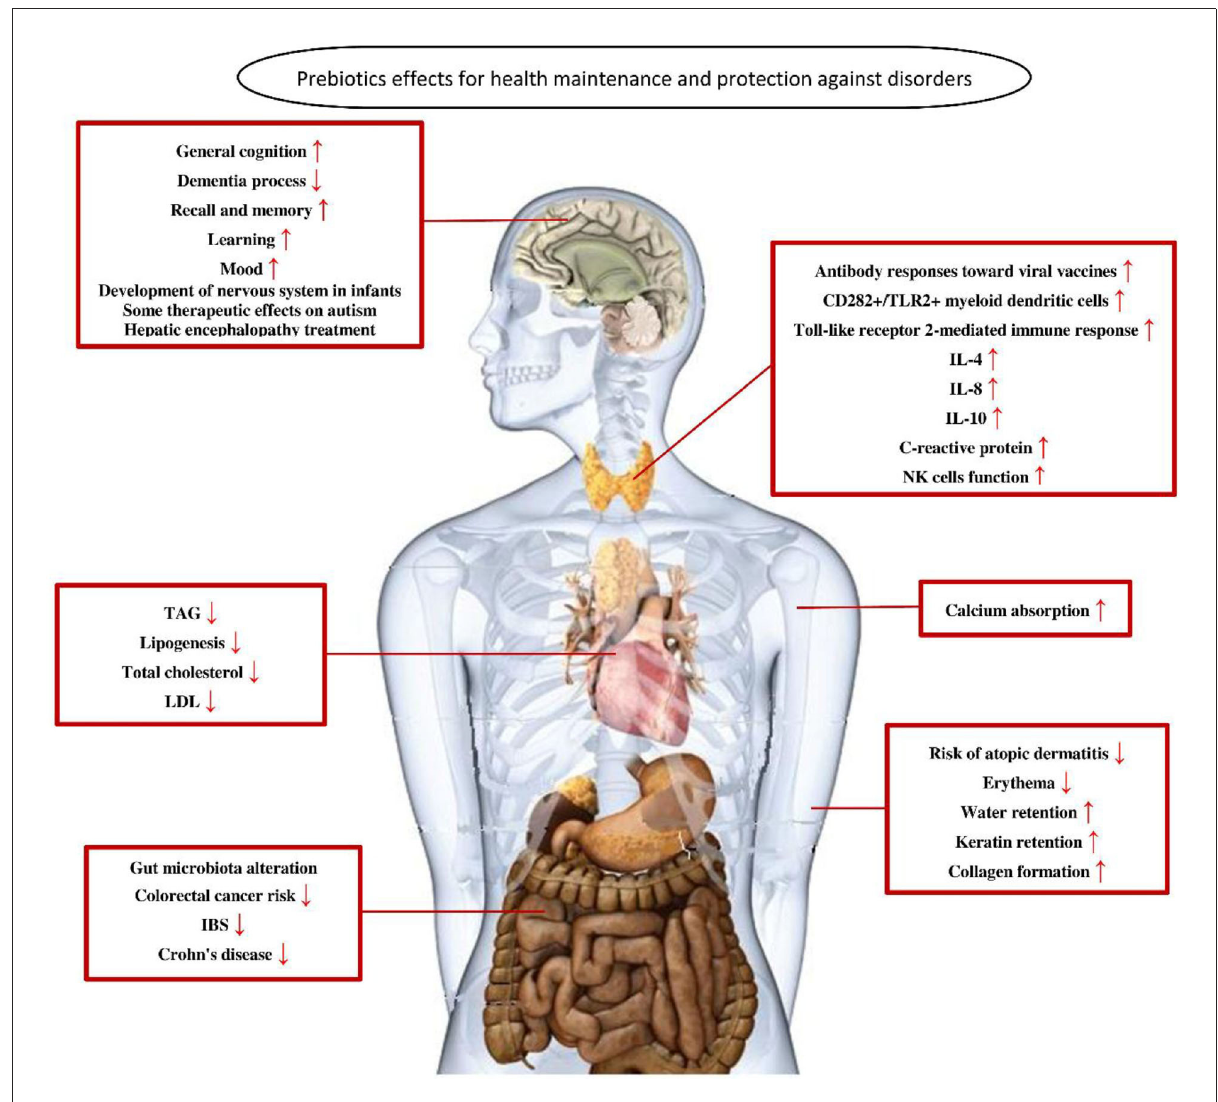
FIGURE3 The role of prebiotics in maintaining health and preventing disorders (68). TAG, triacylglycerol; LDL, low-density lipoprotein; IBS, irritable bowel syndrome; IL-4, interleukin 4; IL-8, interleukin 8; IL-10, interleukin